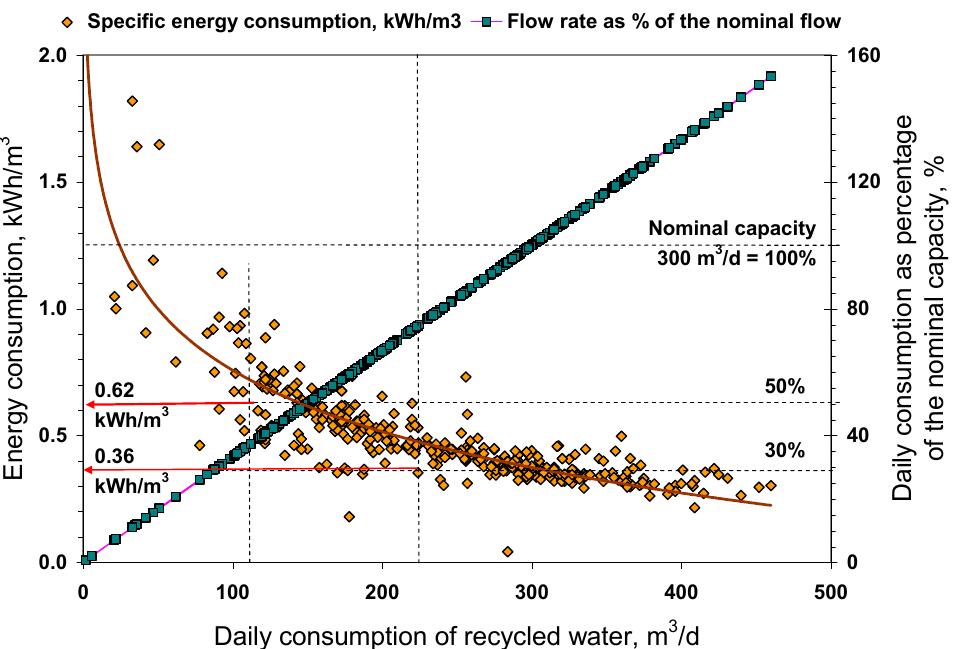
Figure 7. Correlation between the specific energy consumption and the hydraulic flow